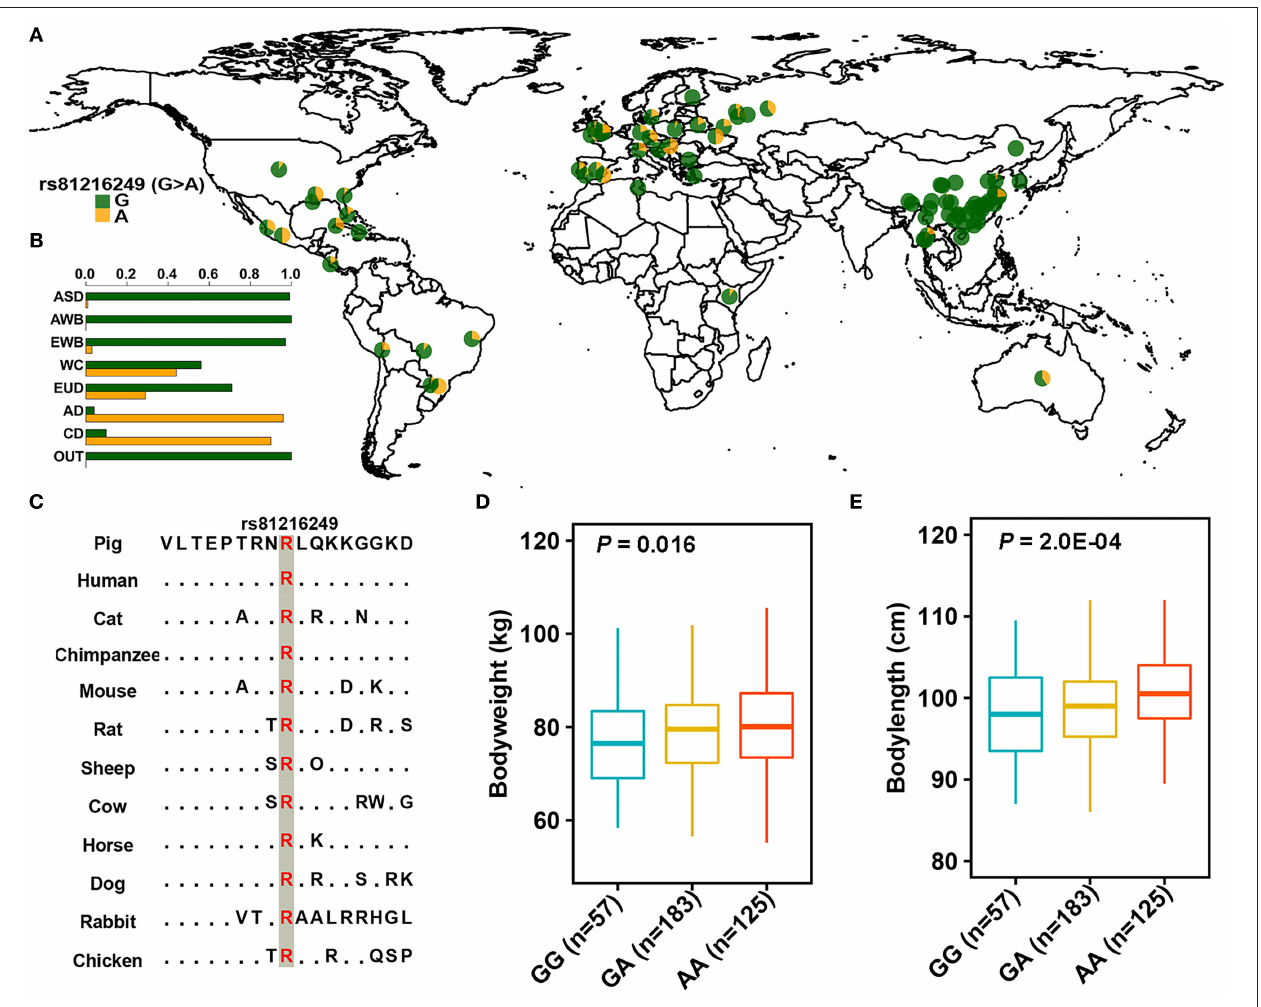
FIGURE 4 | The distribution of rs81216249. (A,B) The allele frequency distribution of rs81216249 in global pig breeds. G and A denote ancestral and derived genotypes and are marked by green and yellow, respectively. ASD, AWB, EWB, EUD, WC, AD, CD, and OUT represent Asian domestic pigs, Asian wild boars, European wild boars, European domestic pigs, Western commercial pigs, American Duroc pigs, Canadian Duroc pigs, and outgroup populations, respectively. (C) Multispecies alignment of the protein sequences around the variant. (D,E) Association analysis of rs81216249 with body weight and body length in Sujiang